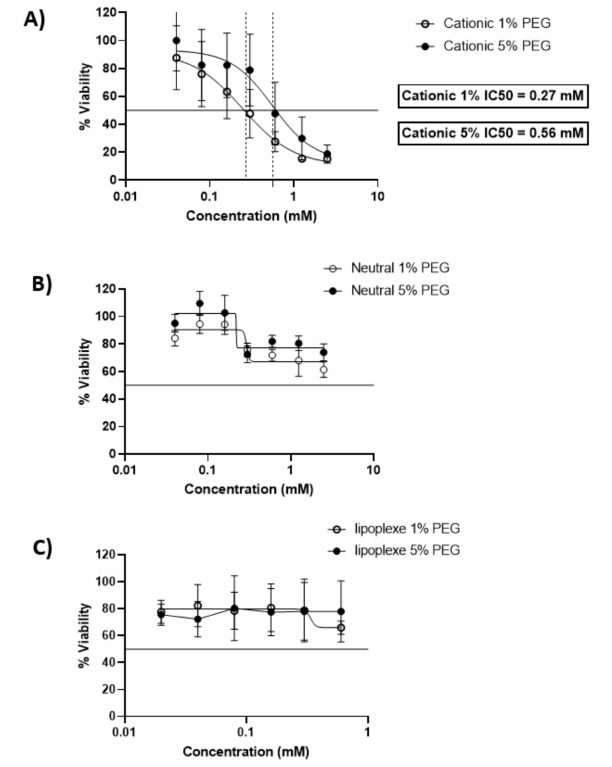
Figure 1. Dose-response curves expressing the viability of BeWo cells after incubation with cationic liposomes ( A ), neutral liposomes ( B ) and lipoplexes ( C ) for 24 h. The x-scale of the lipoplexes MTT ( C ) is different from the liposome graphs ( A , B ). The data represent the results of MTT assay and are expressed as average % cell viability ± SEM against the concentration of the liposomes in mM. Error bars indicate standard deviation for n = 3